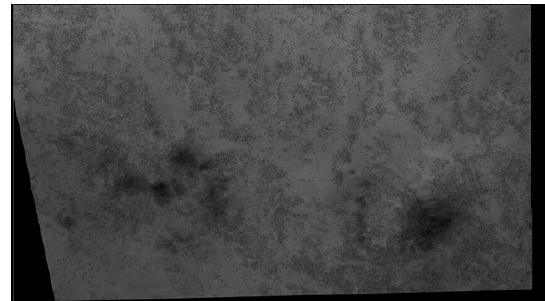
Figure 7. Coherence coefficient diagram